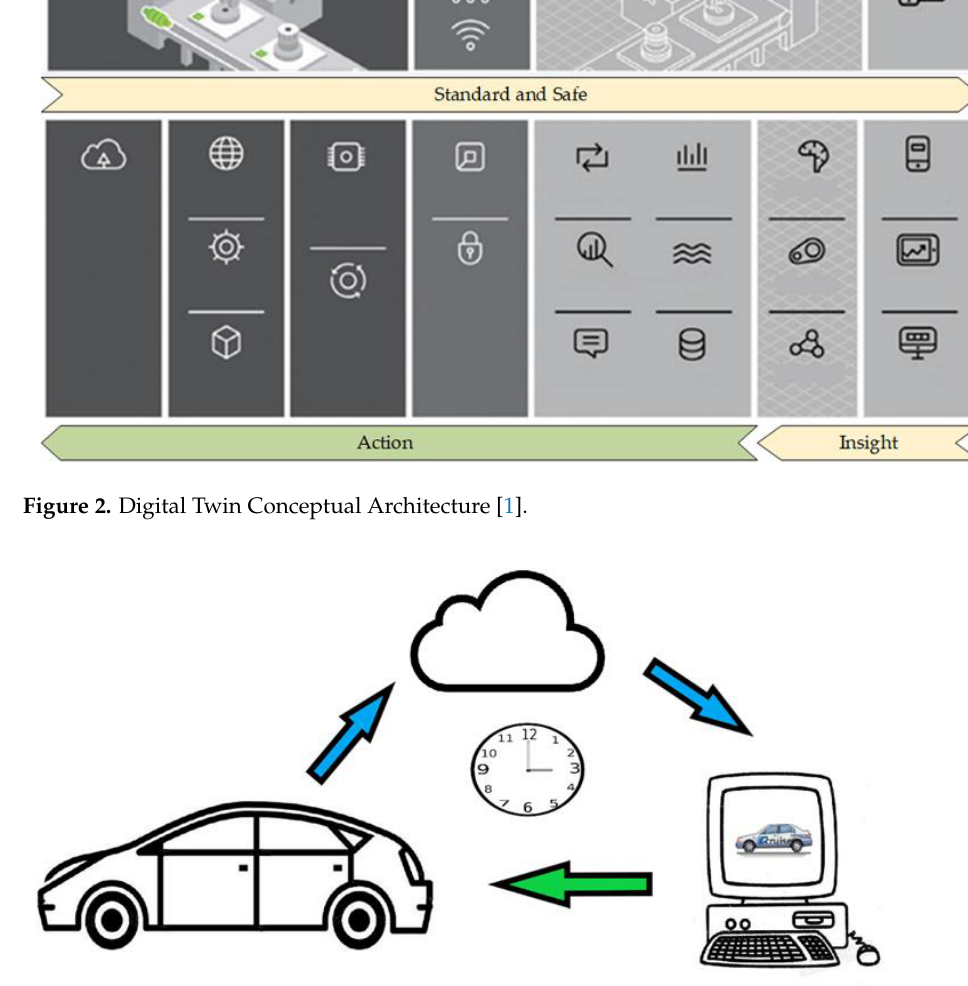
Figure 3. Information transmission diagram of digital twin model of electric vehicle energy con- sumption.